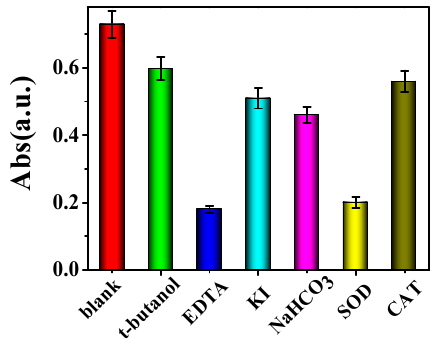
Figure 3. The effects of different scavengers on the oxidation of TMB under visible-light irradiation by PO 43 − -capped CdS QDs.